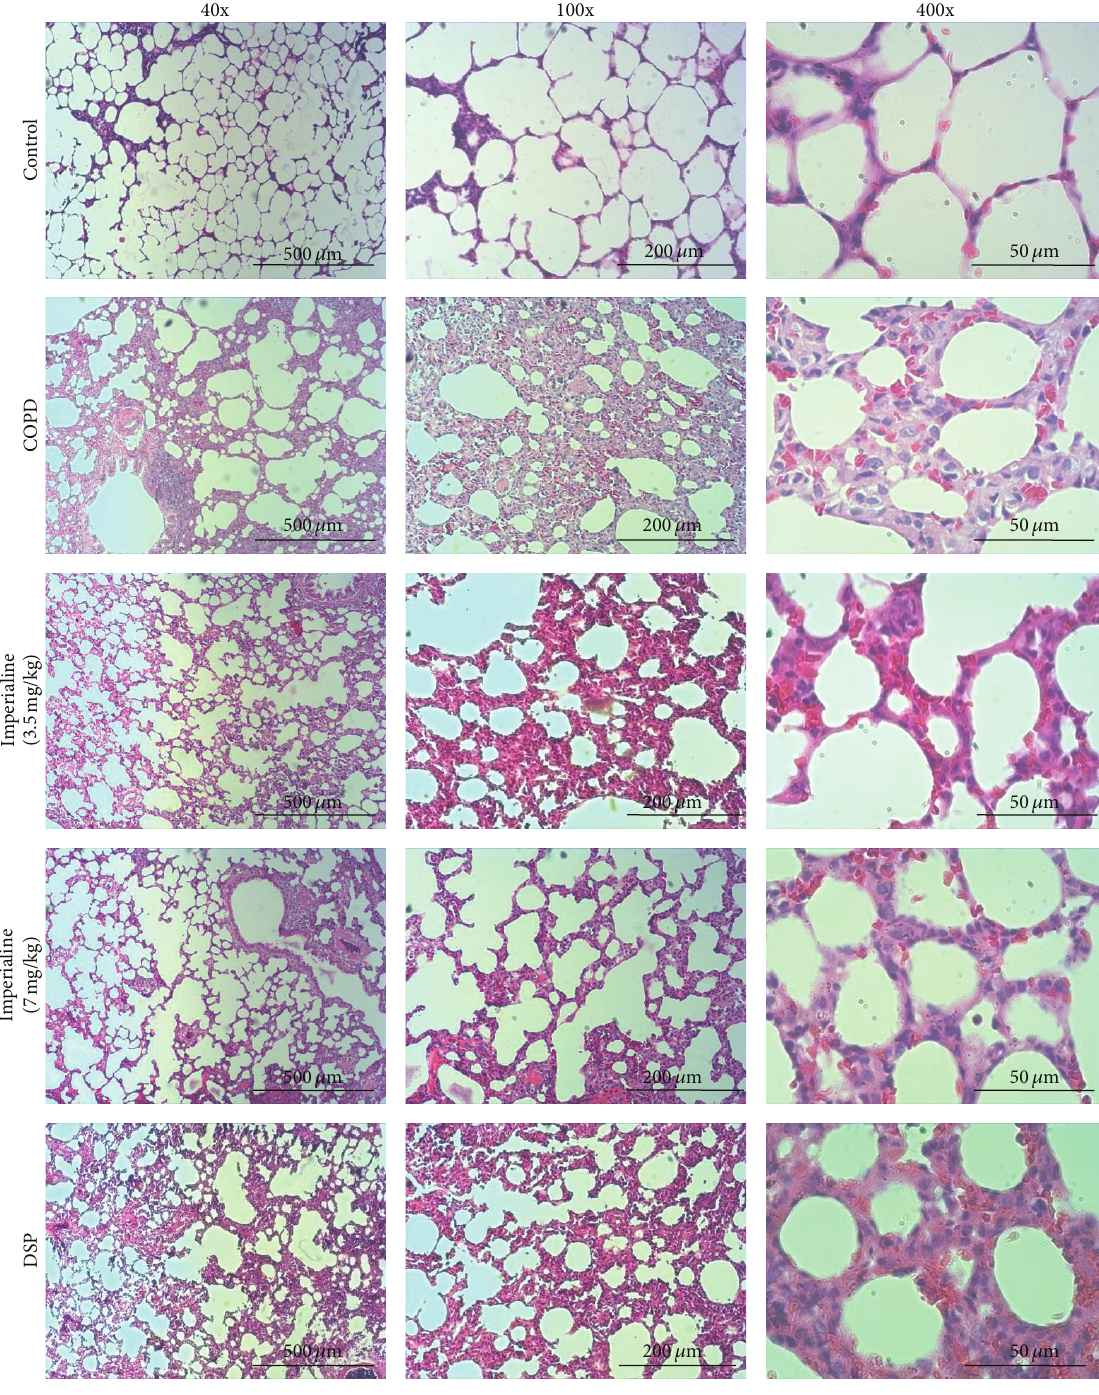
Figure 6: Typical H & E staining images. Histological examination of lung tissues of rats in different groups (magnification: 40x, 100x, and